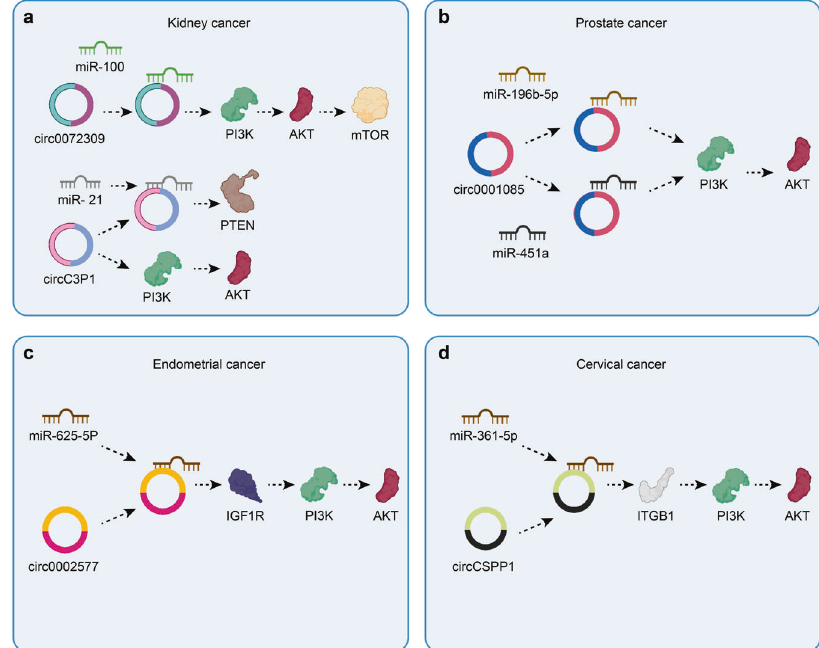
Fig. 4 The speci fi c mechanism of circRNAs and PI3K/AKT pathway in different cancers. a Circ-0072309 sponges miR-100 to inhibit the PI3K/ AKT/mTOR pathway in kidney cancer. CircC3P1 inhibits kidney cancer progression via regulation of miR/PTEN pathways and the PI3K/AKT pathway. b Circ0001085 regulates prostate cancer progression through the PI3K/AKT pathway by sponging miR-196b-5p and miR-451a. c Overexpression of circ0002577 enhances the IGF1R/PI3K/AKT axis to increase the migration, invasion, and proliferation of endometrial cancer cells. d CircCSPP1 expression inhibits cervical cancer cell apoptosis and promotes cell proliferation and migration via the miR-361-5p/ ITGB1/PI3K/AKT axis in cervical cancer. Image created with BioRender